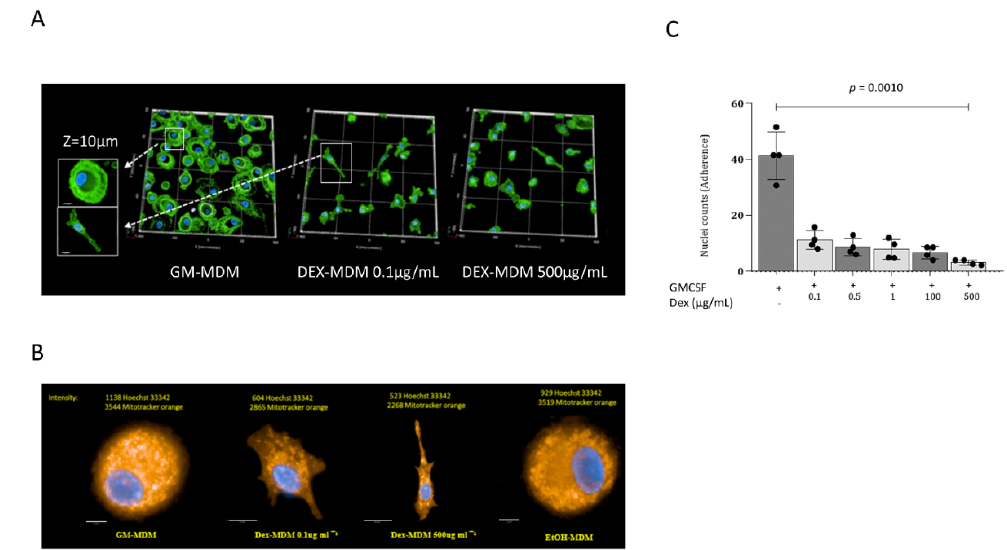
Figure 1. Dexamethasone changes morphology and adherence capacity of macrophages. Representative images show striking differences between untreated GM-MDMs (round morphology, higher adherence) vs. their Dex-treated counterparts (spindle-like morphology, less adherent). While Dex-MDMs illustrate the spindle-like morphology, in EtOH-treated control MDMs, there was no effect on morphology. ( A ) GM-MDMs (1 × 10 6 /mL) were treated with GM-CSF alone or in presence of GM-CSF and increasing concentrations of Dex (0.1 to 500 µ g/mL) for 7 days. Thereafter, cells were fixed and stained using Wheat Germ Agglutinin (WGA) AF488 for cell surface and cytoplasm (green) and Höchst for nuclei (blue). Scale bar, 50 µ m. ( B ) Confluence was quantified in an automated fashion before and after Dex treatment using the Operetta CLS Harmony Software (Perkin Elmer). The values were expressed as mean ± SD, demonstrating the change in confluence following treatment. The x-axis represents treatment conditions, and significance was calculated by ANOVA. ( C ) Mitochondria (orange) were stained using Mitotracker ® CM-H2TMRos and nuclei (blue) were stained using Höchst. Scale bar, 10 µ m. All stainings were repeated at least three times, and a representative is depicted in the Figures.